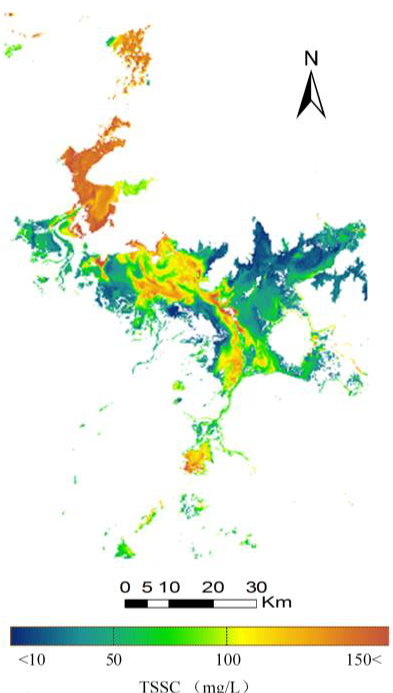
Figure A2. A thematic image of the sediment concentrations in Poyang Lake.